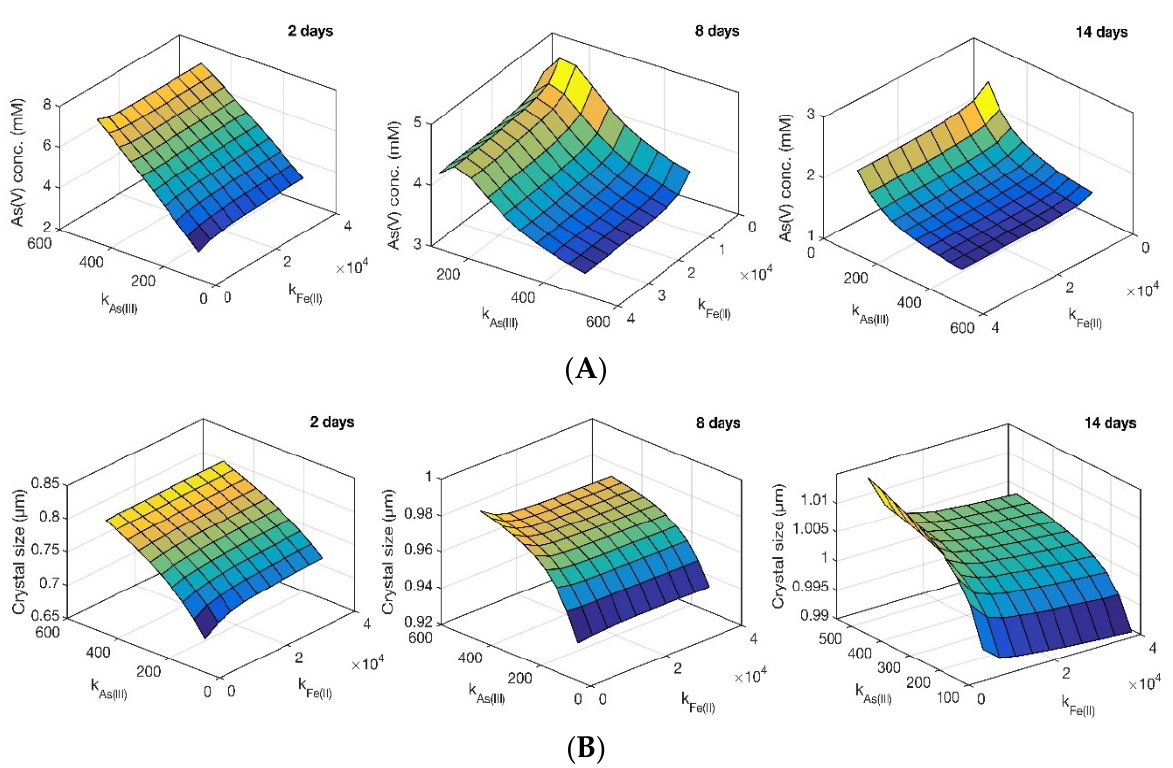
Figure 7. Effect of the oxidation rate constants, k Fe(II) and k As(III) (mM d − 1 g biomass − 1 ) on As(V) precipitation ( A ) and crystal size ( B ) at different culture times.